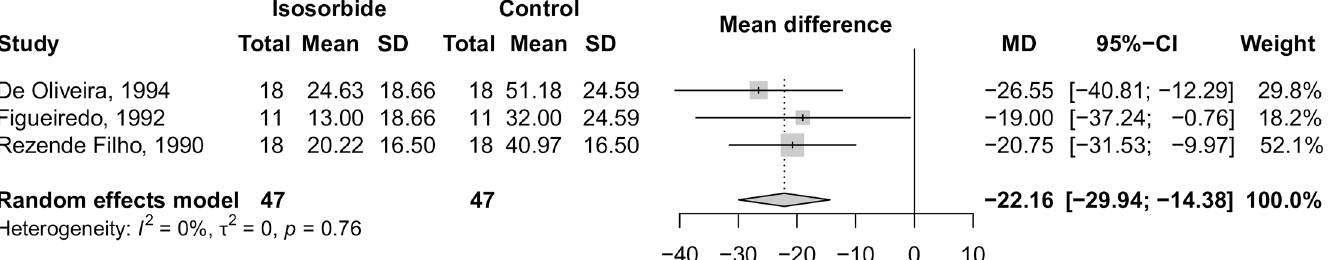
PLOS NeglectedTropical Diseases | https://doi.org/10.1371/journal.pntd.0006836 September 28,